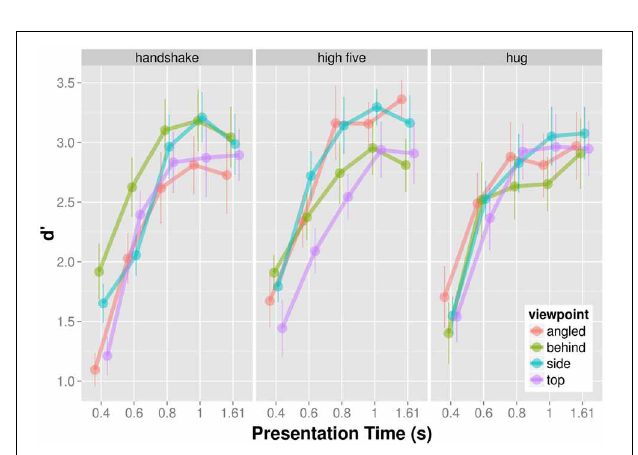
FIGURE 3 | Mean reaction times given for each action and viewpoint separately (collapsed across presentation duration). Bars indicated one standard error from the mean.